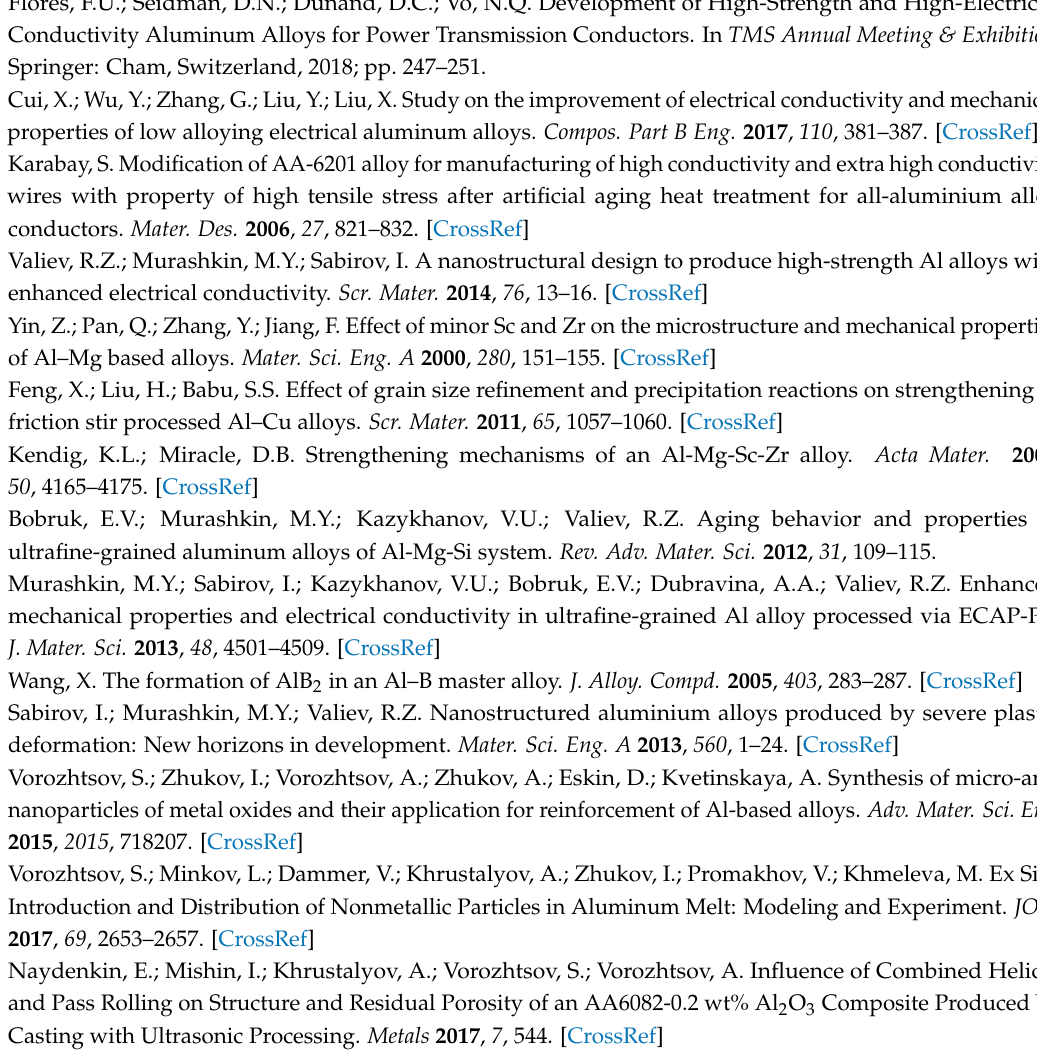
Figure S1: An TEM image of the Al 2 O 3 powder, Figure S2: An SEM image of the Al-TiB 2 alloy (ii) after four SPD